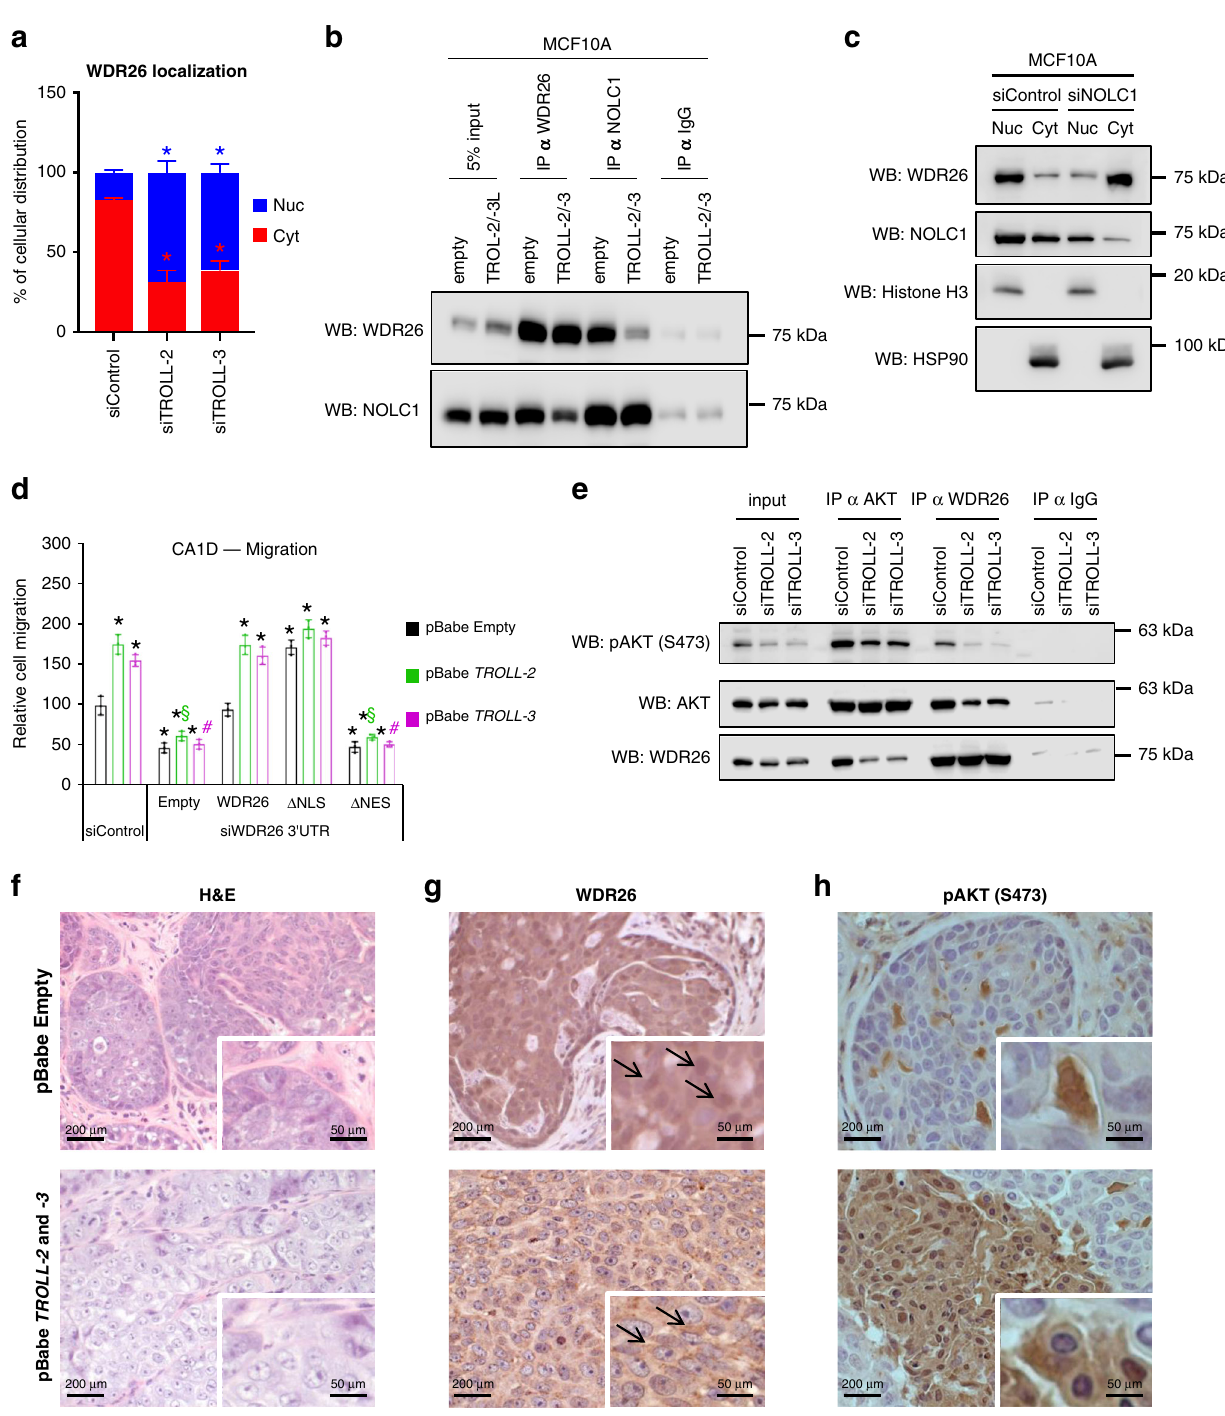
Fig. 6 AKT phosphorylation mediates TROLL-2 and TROLL-3 ’ s functions. a Quanti fi cation of the percentage of WDR26 localization in the nuclear (Nuc) and cytoplasmic (Cyt) fractions of CA1D cells transfected with the indicated siRNAs. Data are mean ± SD and analysed with two-way ANOVA. n = 3 biological replicates, asterisk vs. siControl, P < 0.05. b Representative western blot analysis of the coimmuno-precipitation of endogenous NOLC1 and WDR26 in MCF10A cells transfected with the indicated constructs and siRNAs. c Representative western blot of WDR26 and NOLC1 localization in the nuclear (Nuc) and cytoplasmic (Cyt) fractions of MCF10A cells transfected with the indicated siRNAs. d Quanti fi cation of cell migration of CA1D cells overexpressing either TROLL-2 , TROLL-3 , or empty vector, in combination with the indicated WDR26 constructs and transfected with the indicated siRNAs. Data are mean ± SD and analysed with two-tailed Student ’ s t test, n = 3 biological replicates, asterisk vs. pBabe Empty siControl, P < 0.005. Section vs. pBabe TROLL-2 siControl, P < 0.005. Hash vs. pBabe TROLL-3 siControl, P < 0.005. e Representative western blot analysis of the coimmuno-precipitation of endogenous AKT and WDR26 in CA1D cells transfected with the indicated siRNAs. f – h Representative H&E images ( f ) and IHC for WDR26 ( g ) and for pAKT ( h ) in tumours derived from DCIS cells infected with the indicated constructs ( n = 5 mice for both groups). All blots are representative of n = 3 biological replicates. Source data are provided as Source data fi